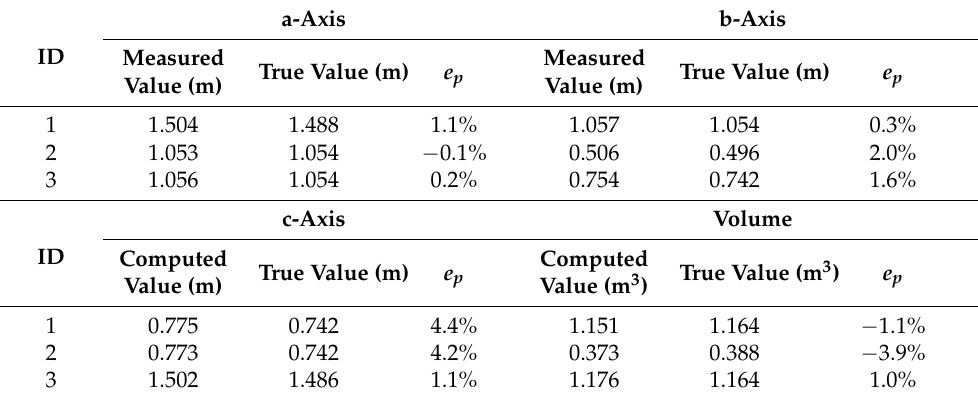
Table 3. Theoretical accuracy of the M3C2